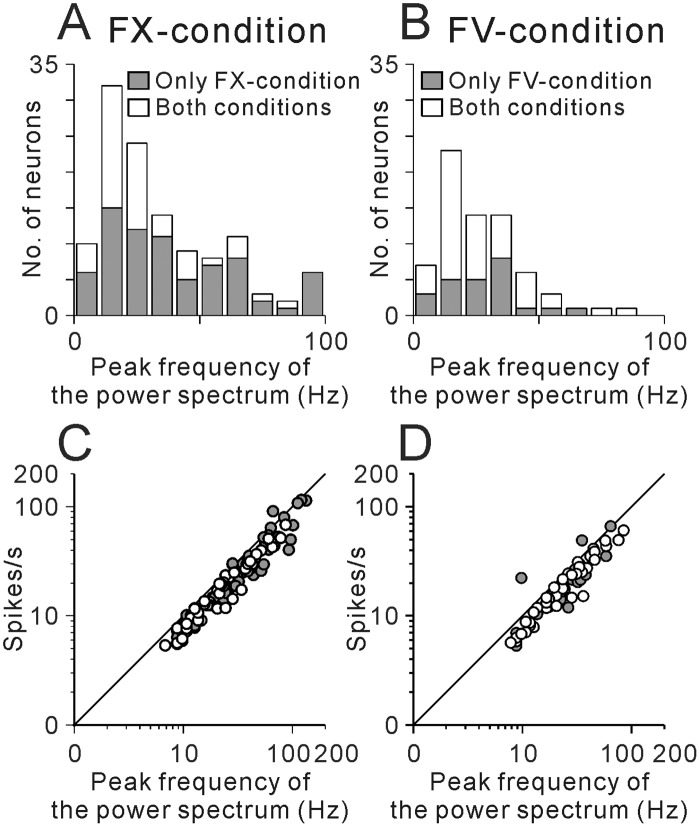
Summary of the frequencies of periodic firing of PPTN neurons.(A, B) Summary histograms of the frequency of periodic firing defined by Fourier analysis. Gray bars indicate neurons that exhibited periodic firing only during the FX-condition (A) or the FV-condition (B), and unfilled bars indicate neurons that exhibited periodic firing throughout the entire behavioral conditions. (C, D) Plots of the mean firing rate vs. frequency of periodic firing during the FX- (C) or FV-conditions (D). Gray circles indicate neurons that exhibited periodic firing only during the FX- (C) or FV-conditions (D), and open circles indicate neurons that exhibited periodic firing throughout the entire behavioral conditions.